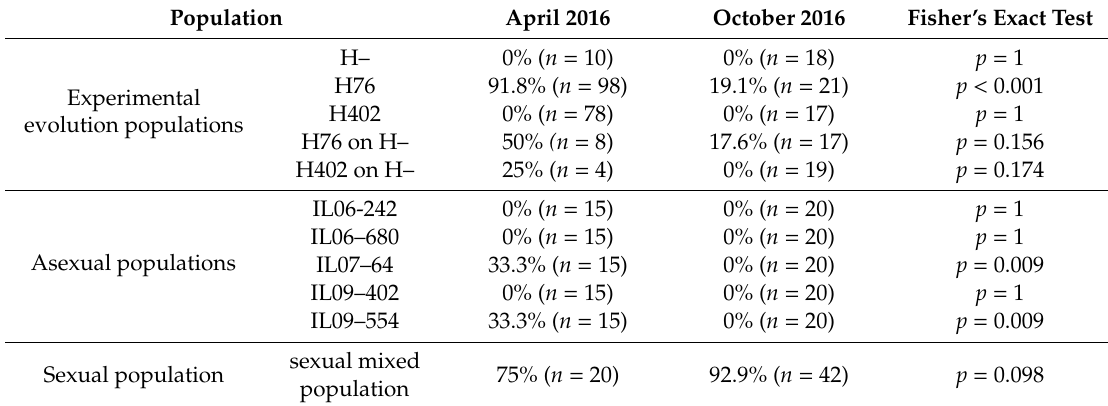
Table 1. Comparison of the infection rates of all tested lab populations between two time points (April and October 2016) by PCR